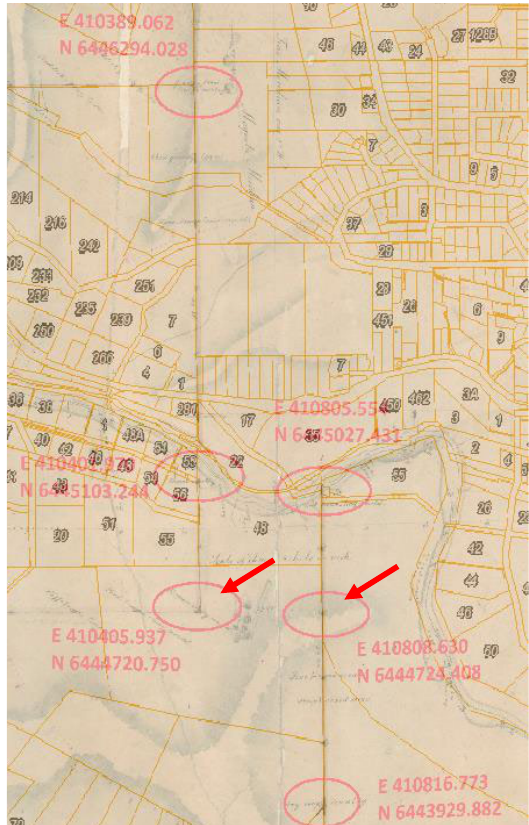
Figure 5: Historical map overlaid with today’s cadastral information in the attempted to geolocate the historical